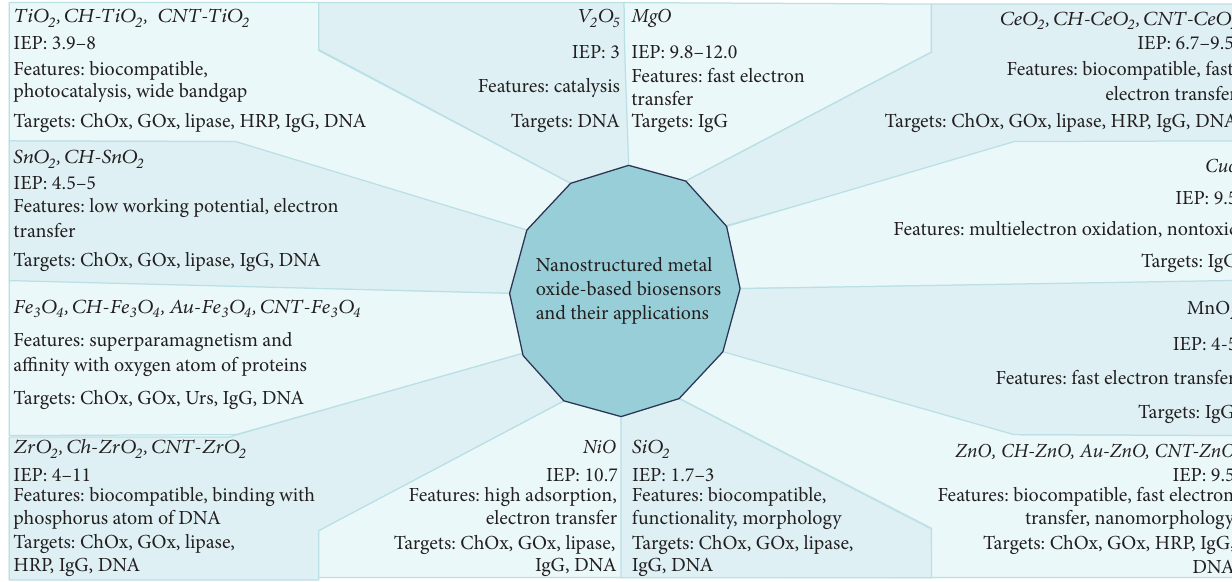
Figure1:Nanostructuredmetaloxide-basedbiosensorsandtheirapplications(IEP,isoelectricpoint;ChOx,cholesteroloxidase;GOx,glucose oxidase; HRP, horseradish peroxidase; IgG, Immunoglobulin G; Urs, urease) [9].